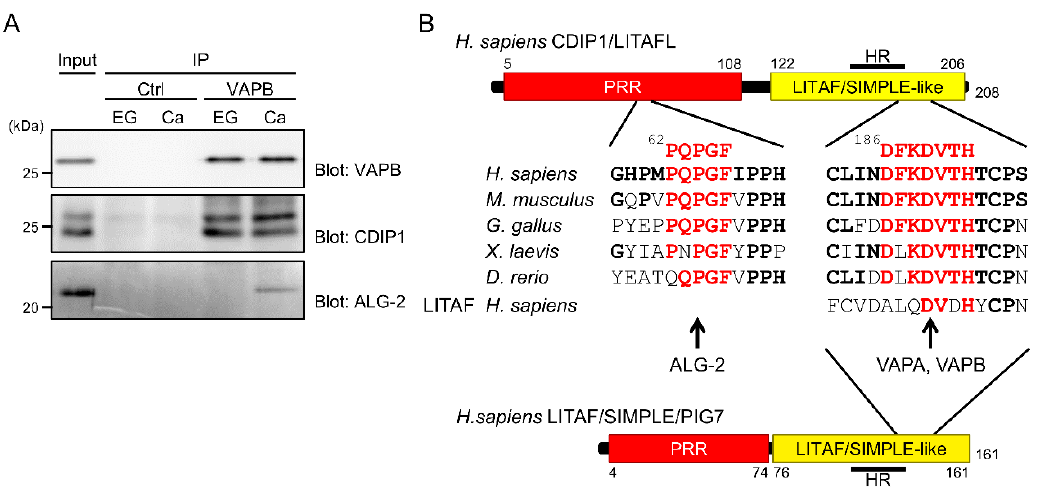
Figure 10. Ca 2+ -dependent ternary complex formation between VAPB, CDIP1 and ALG-2. ( A ) Co-IP assay of BFA-treated HEK293 cells. Cells were treated with BFA for 9 h, and the cleared cell lysate was immunoprecipitated with a polyclonal antibody against VAPB (VAPB) or control IgG (Ctrl) in the presence of 5 mM EGTA (EG) or 10 μ M CaCl 2 (Ca). Cleared cell lysates (Input) and IP products (IP) were subjected to SDS-PAGE followed by immunoblotting with antibodies against VAPB, CDIP1 and ALG-2. The relative amounts of cleared cell lysate proteins (Input) used for analysis of IP products (IP) were 40% (upper panel) and 0.5% (middle and lower panels). ( B ) Alignment of the ABM-2-like motif and the FFAT-like motif of CDIP1 homologs from humans (Q9H305), mice (Q9DB75), chickens (A0A1D5PGK0), flogs (Q8AVW3) and zebrafish (A6H8U1) and the FFAT-like motif of human LITAF (Q99732). Residues conserved among CDIP1 homologs and LITAF are indicated in red. HR, hydrophobic region.